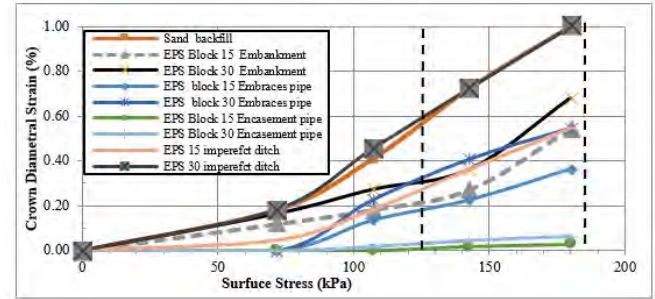
Figure 12. Crown diametral strain of UPVC buried pipe in case of different backfill models.